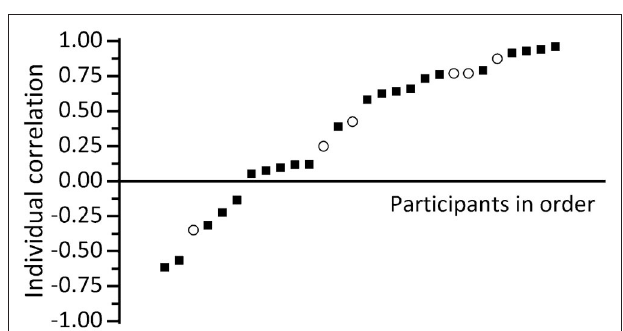
FIGURE 11 | Plot of individual correlation between salivary cortisol and our stress-induced cortisol estimation (ESIC) based on DTI-4 skin conductance data for high-cortisol responders [black squares ( n = 22)] and low-cortisol responders [open circles ( n = 6)].